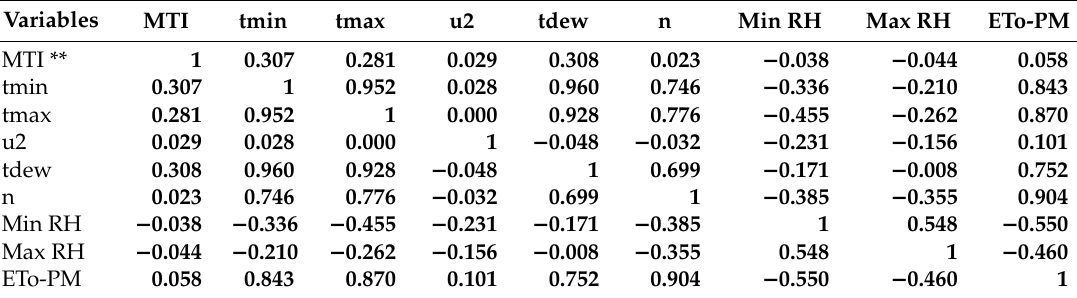
Table 2. The correlation matrix of the meteorological variables *.